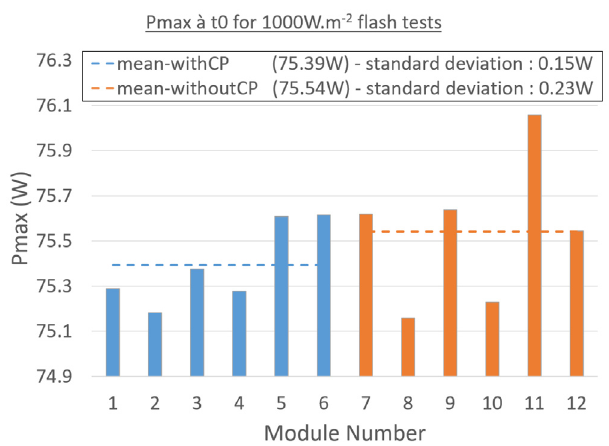
Fig. 10. Initial fl ash tests results for the